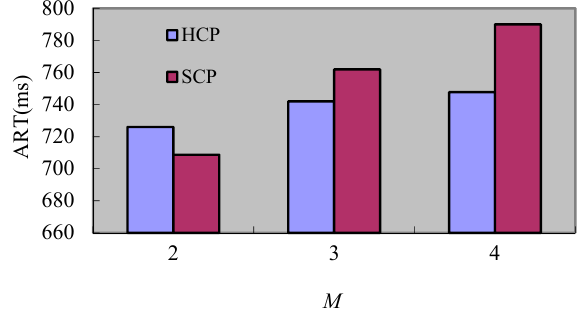
Figure 11. Impact of M on ART. Sensors 2017 , 17 , 2166